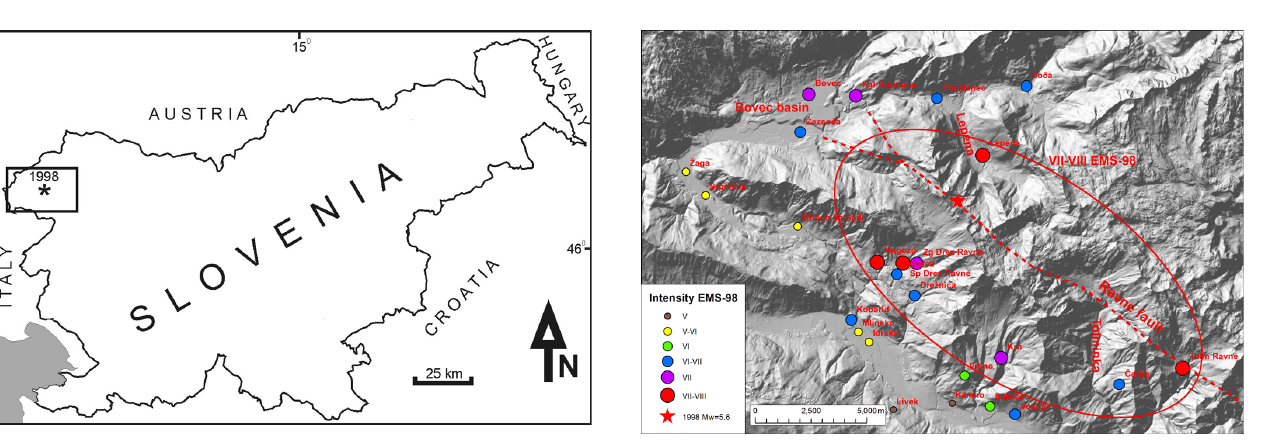
Fig. 2. Intensity map (EMS-98) of 12 April 1998 M w = 5.6 earth- quake (data courtesy of Ina Ceci´c; Zupanˇciˇc et al., 2001) with ten- tative VII–VIII EMS-98 isoseismal line. The trace of the causative Ravne fault is also